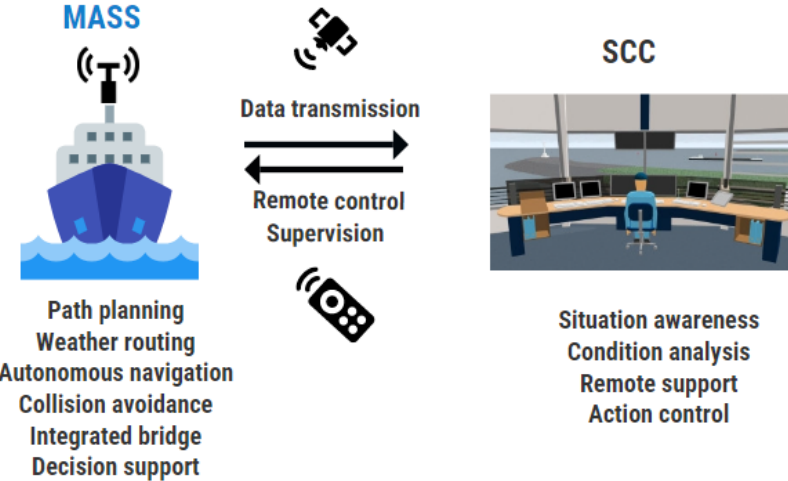
Figure 2. Relationship between MASS and shore control centres (SCC).